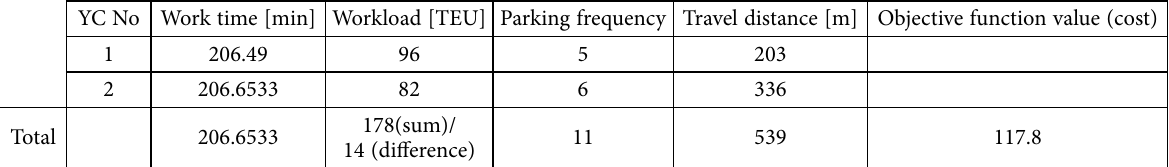
Table 4. The scheduling results of YCs by two-stage hybrid